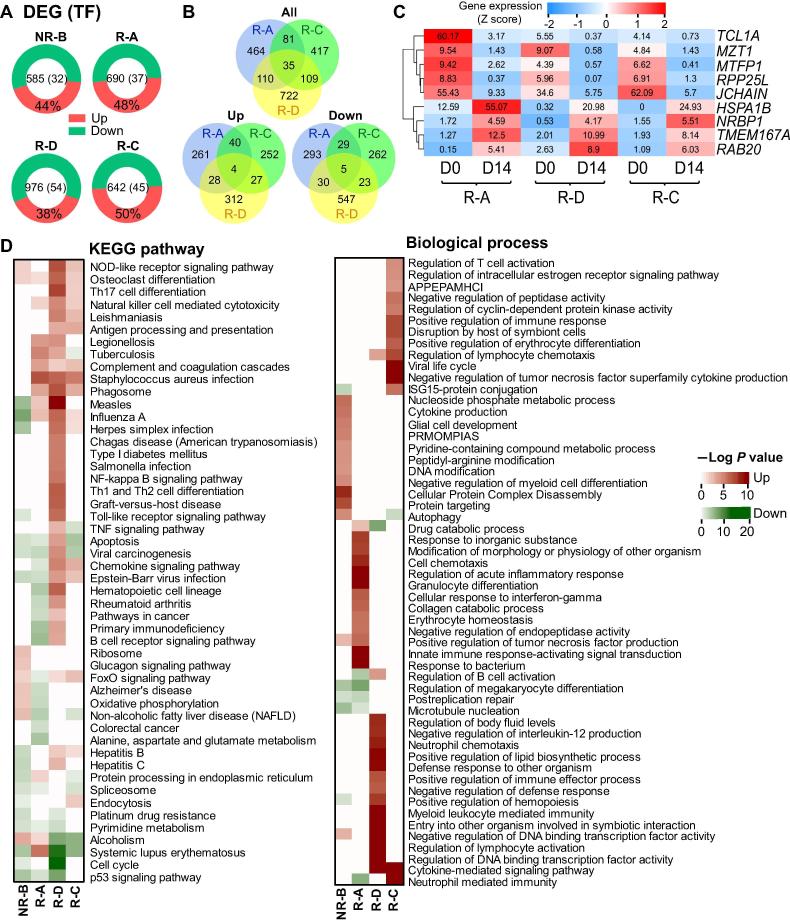
The expression profile and functional enrichments of DEGs in BM samples after CAR-T infusionA. The distribution of DEGs across the four patients with the percentage of the up-regulated DEGs provided. The number of total DEGs and those encoding TFs in each patient is presented in the center. B. Venn diagrams showing all (top), up-regulated (bottom left), and down-regulated (bottom right) DEGs that are common or specific across the three remissive samples, respectively. C. The heatmap demonstrating the common DEGs with the same expression tendency after CD19-CAR-T therapy in three remissive patients. The number in each cell indicates the expression value, while the color keys represent the expression tendency of genes after CD19-CAR-T therapy (blue: down-regulated, red: up-regulated). D. The heatmaps showing the enrichment of DEGs in terms of the KEGG pathways (left) and GO biological processes (right). The up-regulated DEGs enriched terms were shown in red, while the enriched results of down-regulated DEGs were in green. The P values were calculated using Fisher's exact test and log-transformed. “Up” and “Down” represent DEGs with up-regulated and down-regulated expression in D14 sample when compared to D0 sample in each patient, respectively. DEG, differentially-expressed gene; APPEPAMHCI, antigen processing and presentation of exogenous peptide antigen via MHC class I; PRMOMPIAS, positive regulation of mitochondrial outer membrane permeabilization involved in apoptotic signaling.